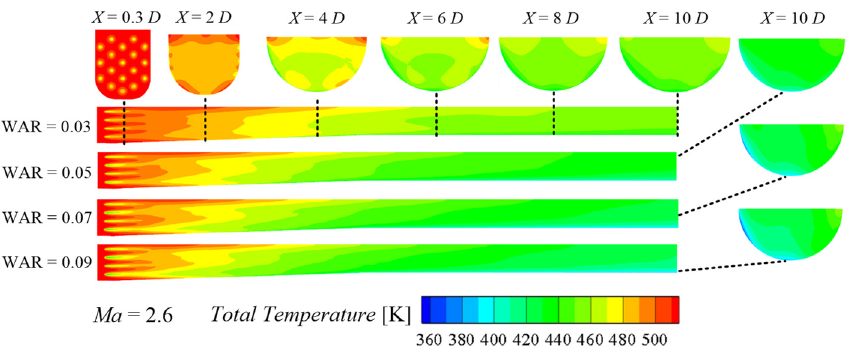
Figure 12. Total temperature at different sections.